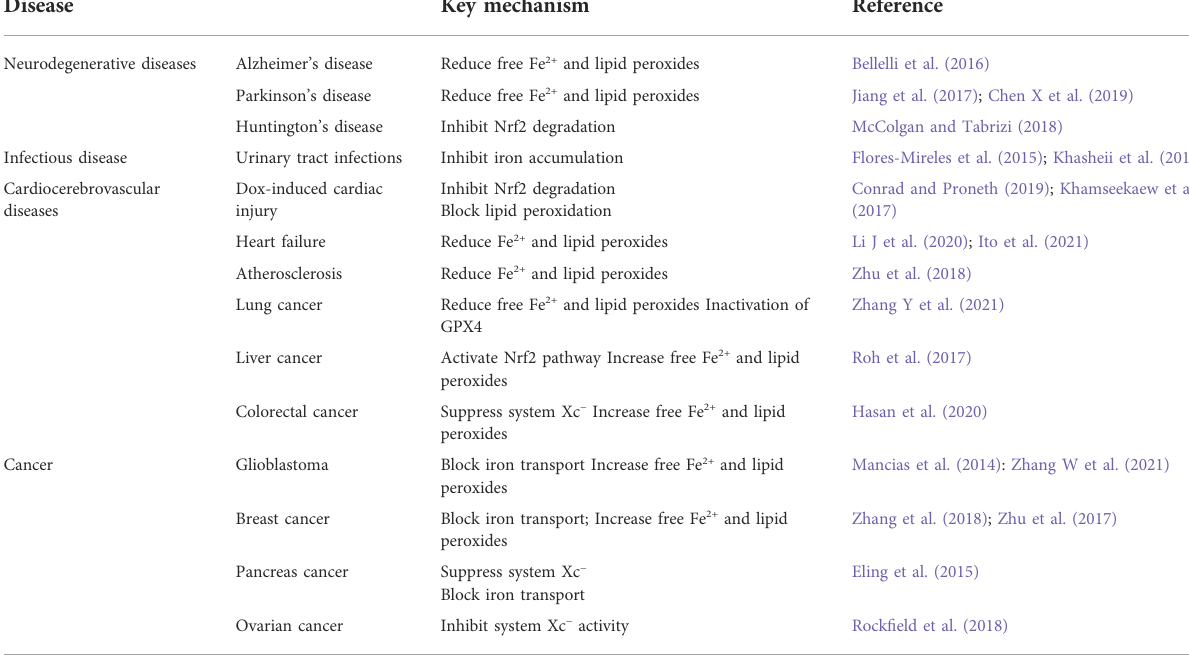
TABLE 1 Treatment strategies of ferritinophagy-mediated ferroptosis in related diseases.